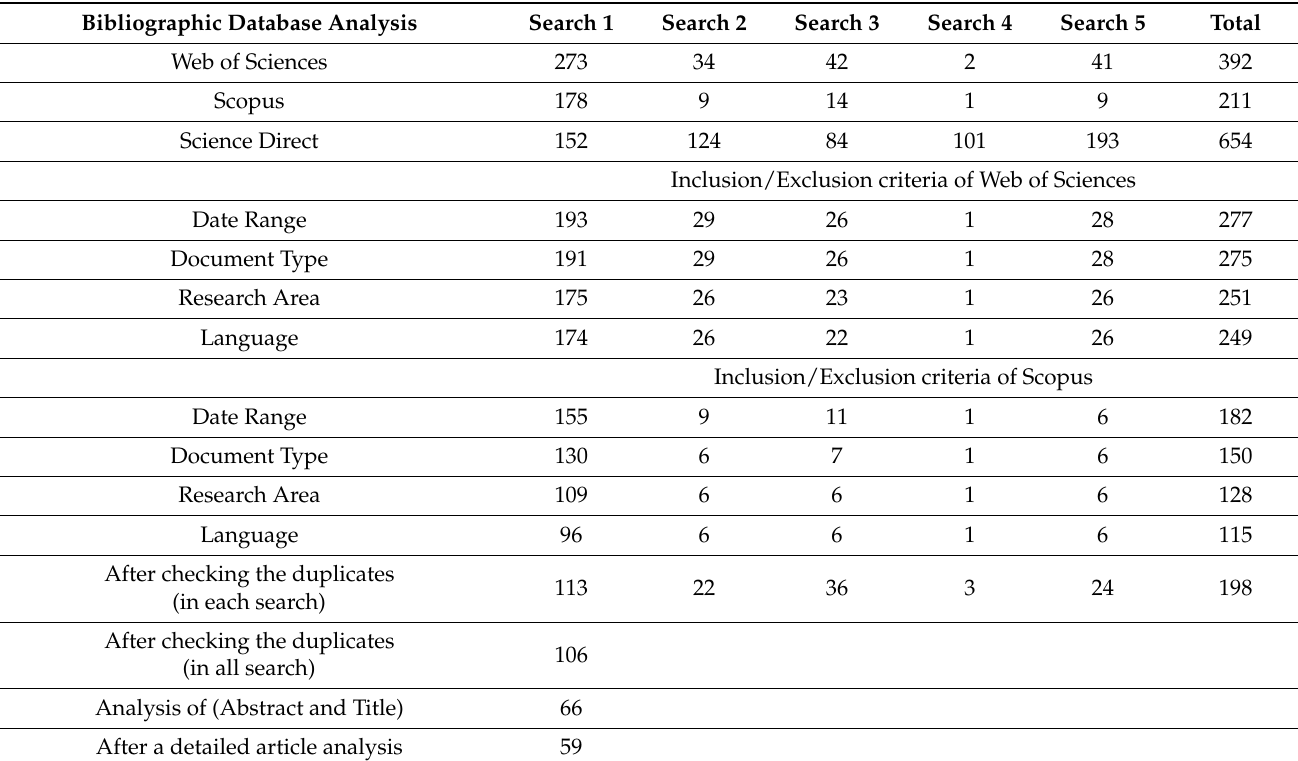
Table 4. Summary of articles preferences and